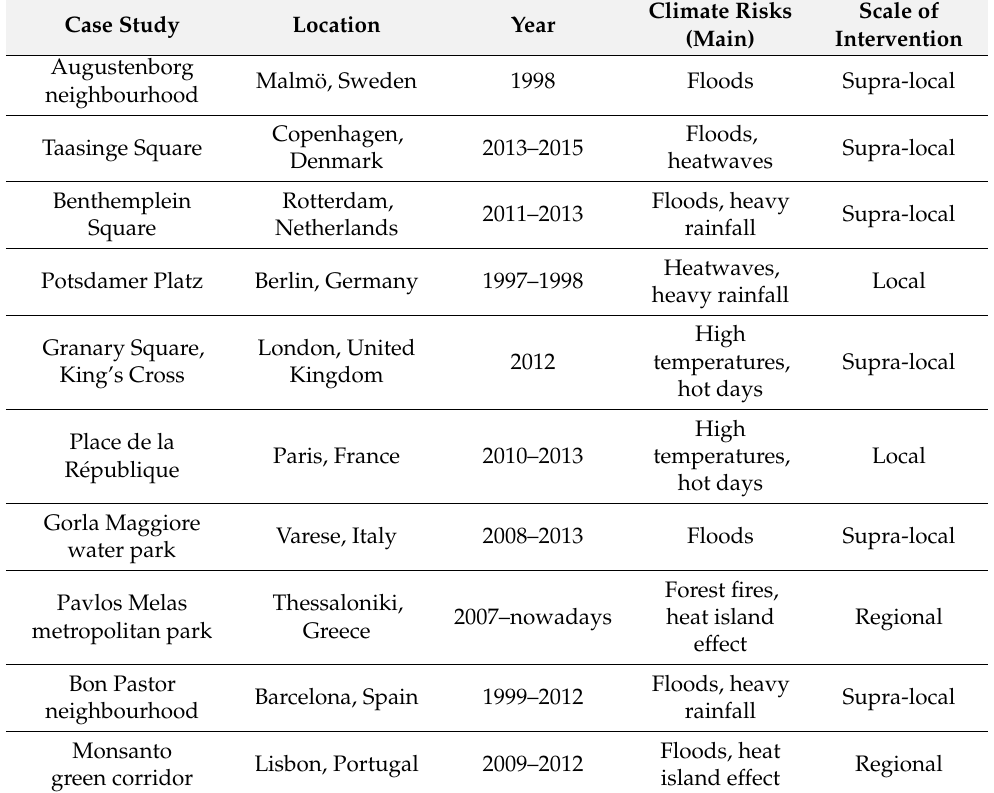
Table 1. Selected 10 local experiences from compact